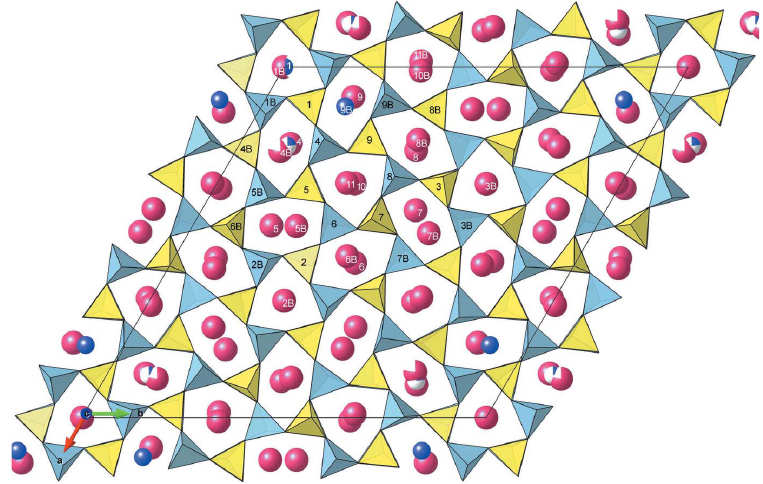
Figure 5 A unit cell of kaliophilite in space group P 3, a = 27.06 and c = 8.56 A ˚ . Si tetrahedra are shown in yellow, Al tetrahedra are shown in sky blue, Na cations are shown in blue and K cations are shown in red.